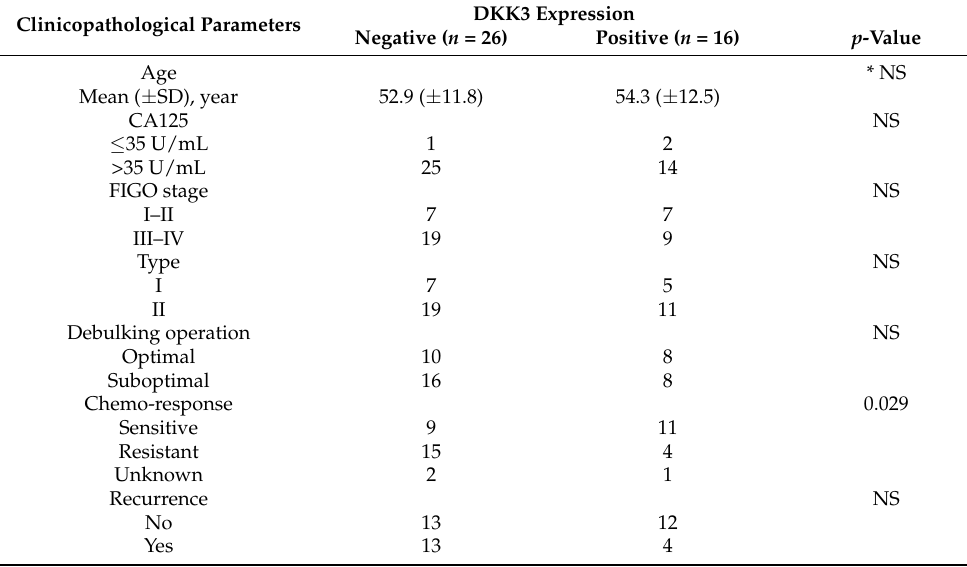
Table 3. Clinicopathological characteristics of women with/without DKK3